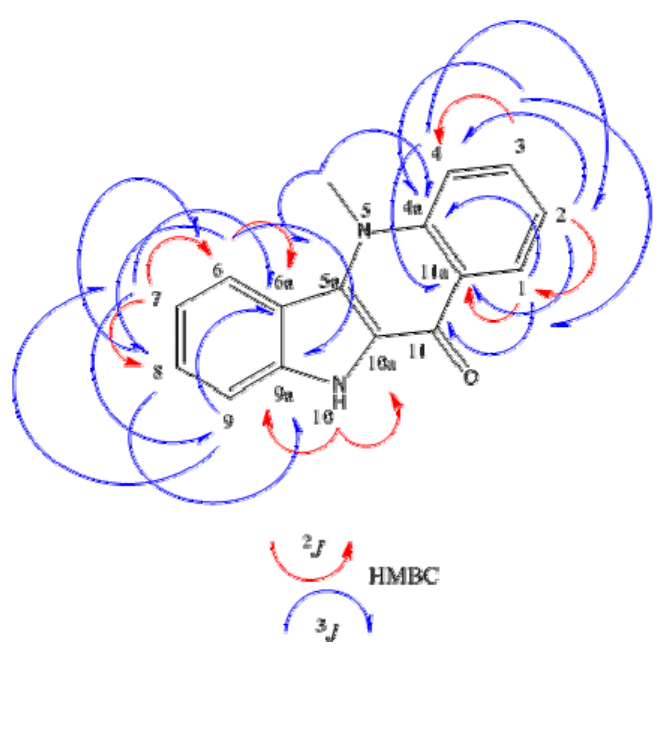
Figure 1. HMBC correlations of compound 8